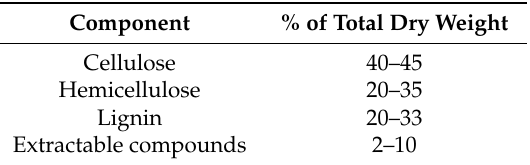
Table 1. Basic composition of white oak wood.